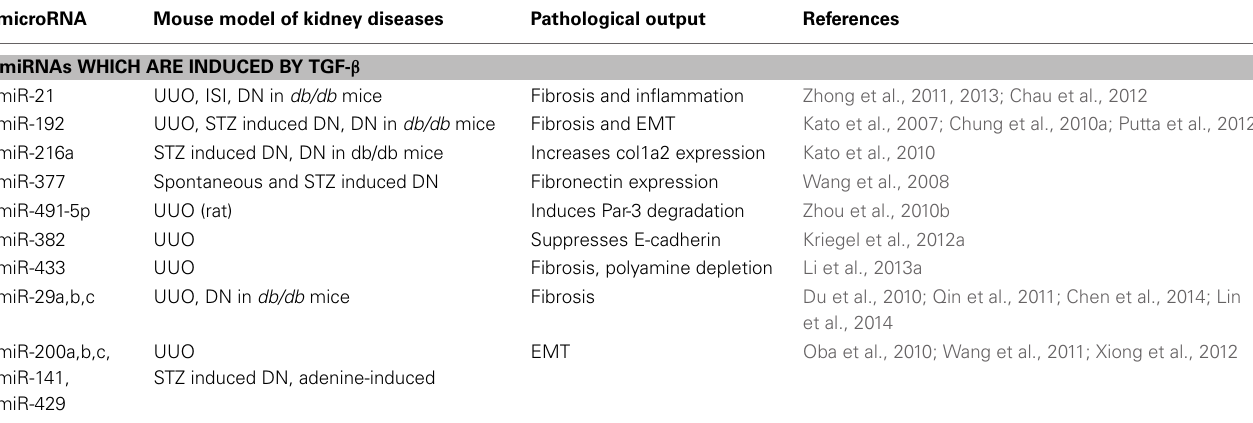
Table 1 | Roles of microRNAs in animal models of kidney